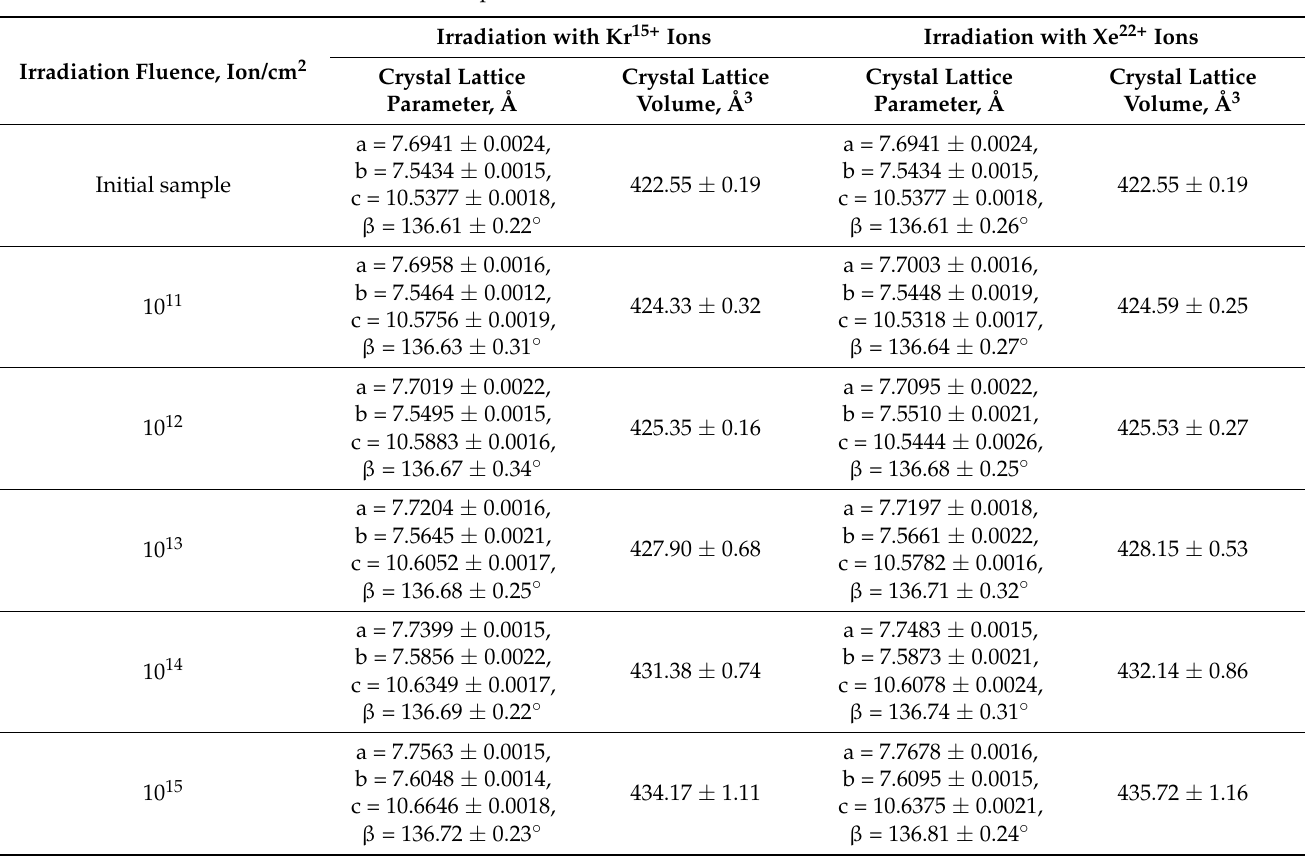
Table 1. Lattice parameter